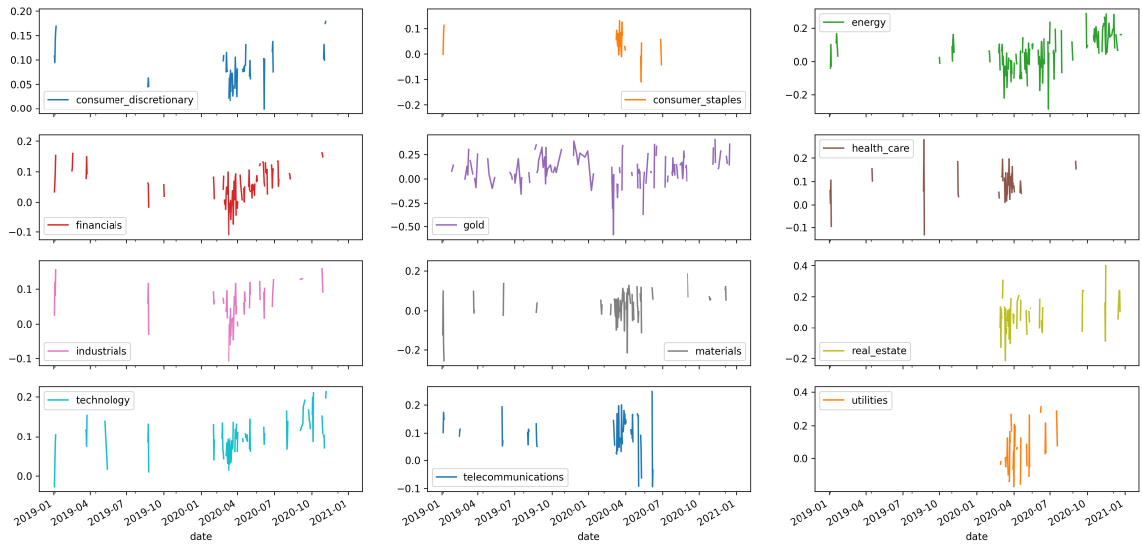
Figure 3. Daily Sentiment for each